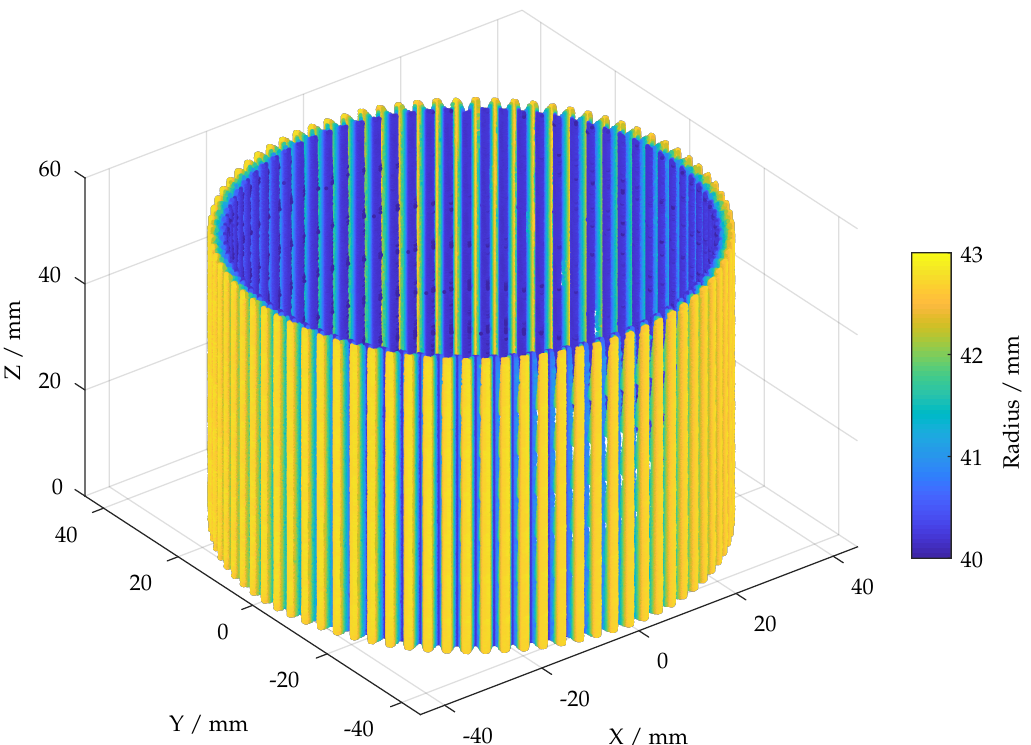
Figure 18. Final point cloud, according to flowchart Figure 8 (downsampled to 10 % of the actual